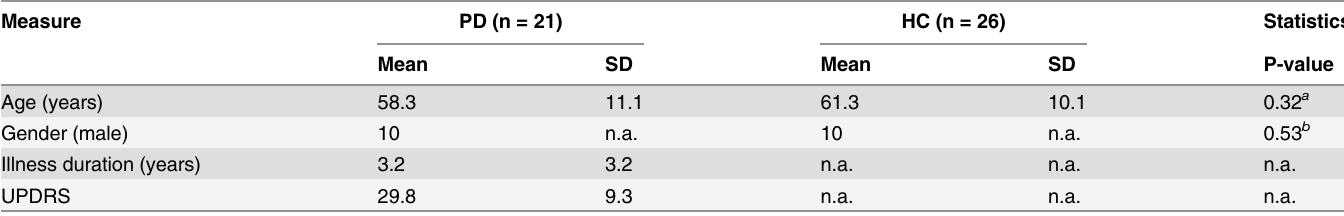
Note: PD = Parkinson ’ s disease, HC = healthy controls, UPDRS = uni fi ed Parkinson ’ s disease rating scale, n.a. = not applicable, a Two-sample t-test, b Pearson Chi-square